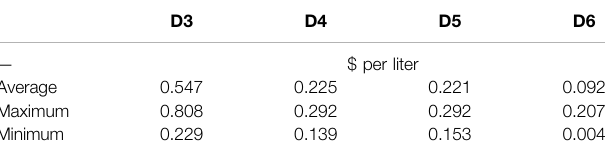
TABLE 8 | RIN values increased by the equivalent value BTU adjustment over the last 9 Months, i.e., December 2019 to August 2020.